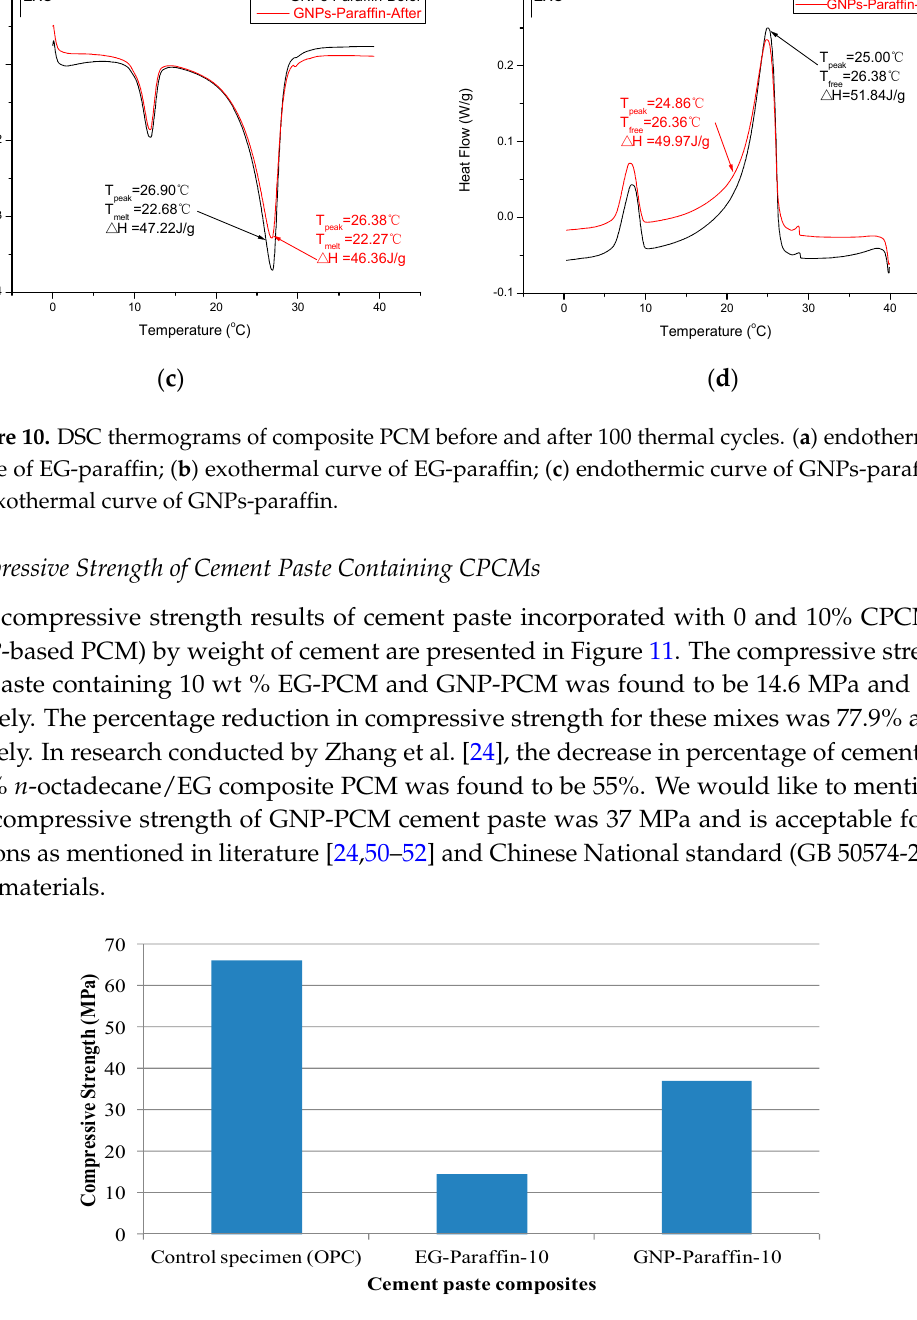
Figure 11. Compressive strength of cement paste incorporated with 0 and 10 wt % CPCMs (EG and GNP-based PCM).